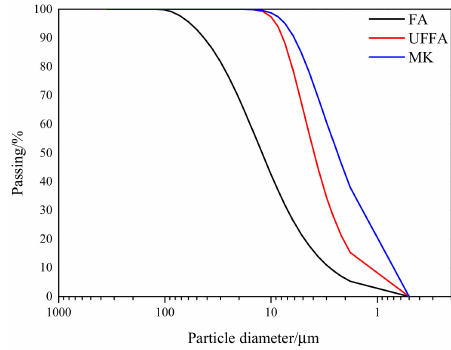
Figure 1. Scanning electron micrograph of SCMs: ( a ) FA, ( b ) UFFA, and ( c ) MK.